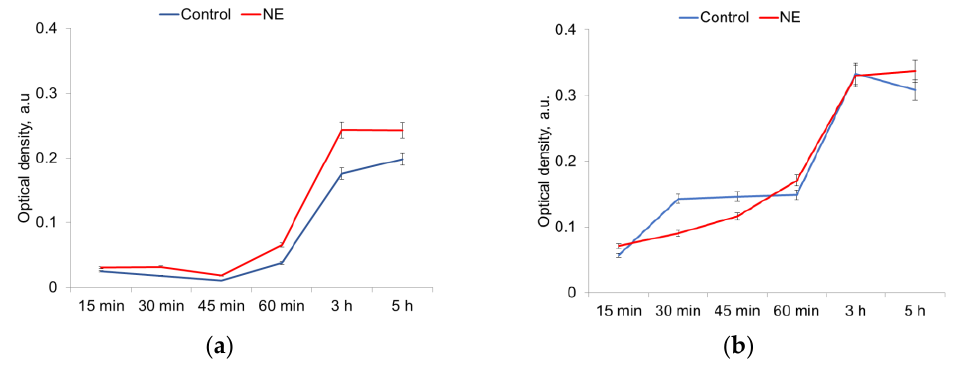
Figure 6. NE effect on adhesion of E. coli ( a ) and S. aureus ( b ) cells.